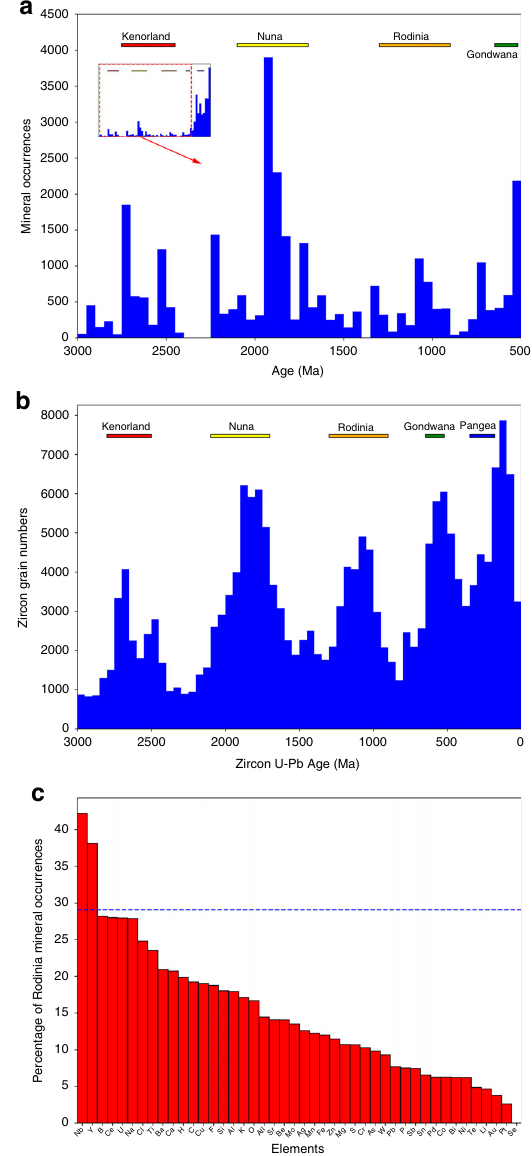
Fig. 1 Temporal distribution of global high-T minerals and detrital zircons. Igneous, metamorphic, and hydrothermal minerals ( a ) and detrital zircons ( b ) through the last 3.0 Ga, with a bin size of 50 Ma. Mineral occurrence is de fi ned in the Methods section. Detrital zircon distribution data is based on ref. 24 . In spite of the signi fi cant preservation bias toward the present, high- T minerals are generally enriched during supercontinental assemblies, similar to detrital zircons. During Rodinian assembly, high-T minerals are relatively less abundant compared to other supercontinents Panel a displays 3000-500 Ma; inset displays 3000-0 Ma. c A survey based on mineral chemistry showing relative abundances of minerals containing different elements. Y -axis is de fi ned as the percentage of entry numbers of speci fi c minerals occurring during RA relative to total entry numbers of those minerals occurring during assemblies of all pre-Pangia supercontinents (dashed blue lines: the percentage of detrital zircon). Except for Nb-bearing and Y-bearing minerals, most minerals are relatively depleted compared to detrital zircon during Rodinia